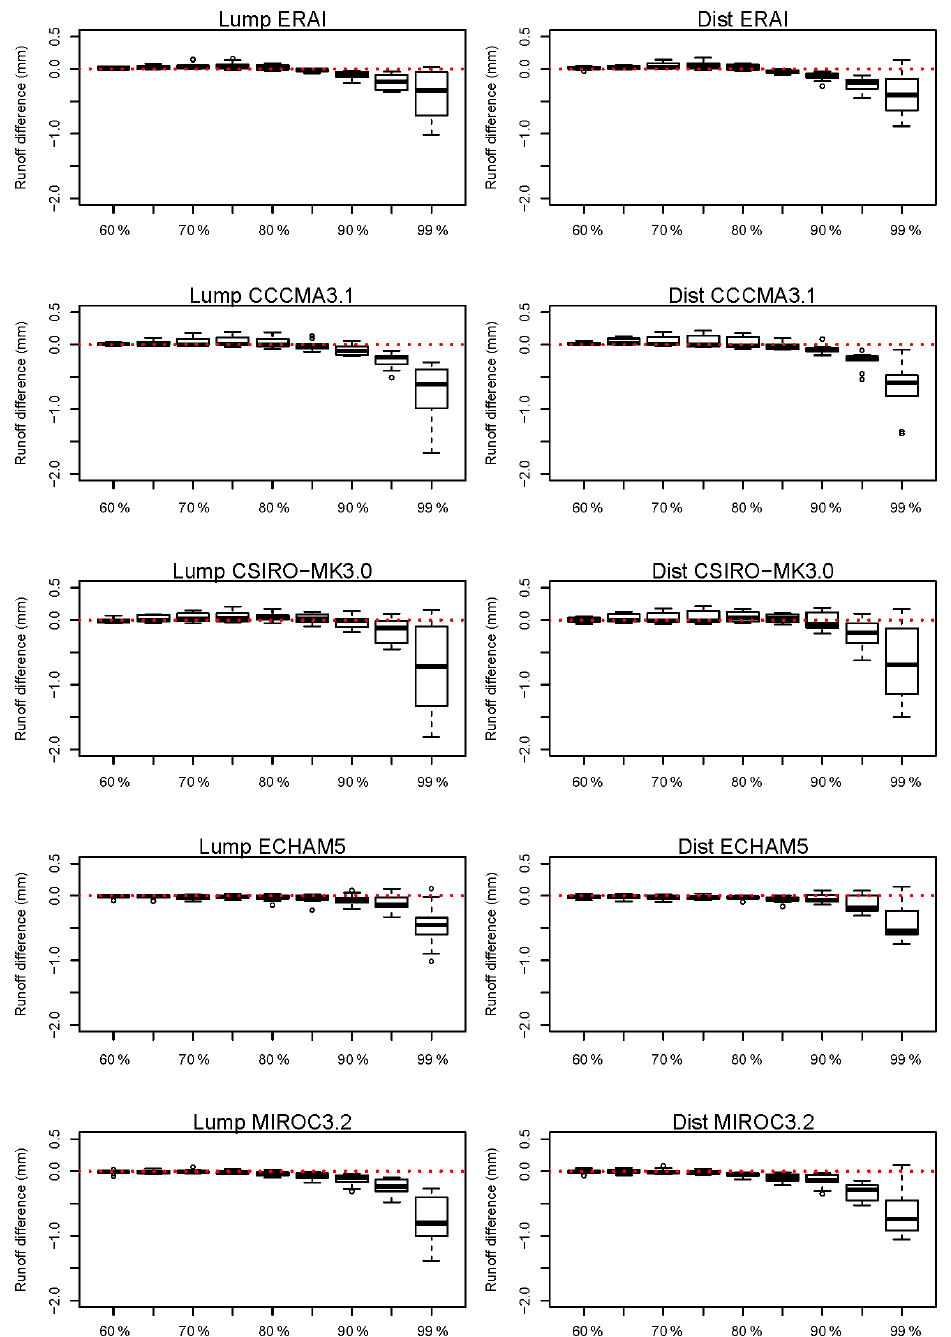
Figure 9. Simulated historical-period runoff high-flow percentile bias (simulation using WRF-BC rainfall minus simulation using AWAP rainfall) of the 60th to 99th daily percentiles for lumped (left) and distributed (right) simulations. Negative values indicate WRF-BC-derived results are smaller than AWAP-derived results. Box plots show the range across the 10